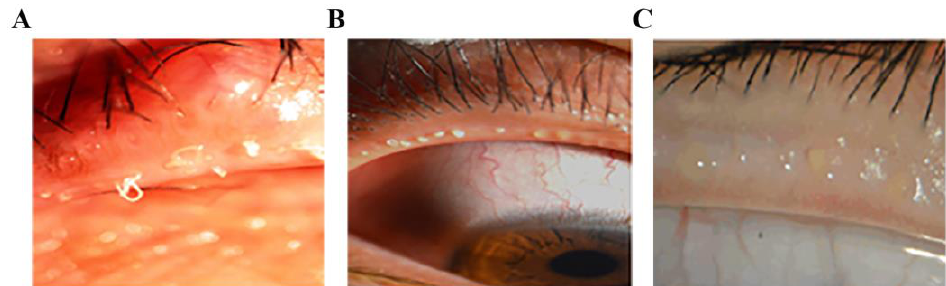
Figure 1. Typical clinical images of MGD patients. The photos of severe MGD ( A , B ) and mild MGD ( C ) patients show that the meibomian gland opening was blocked by white keratin and protruded, and the extruded secretion was like foam, granule or toothpaste.